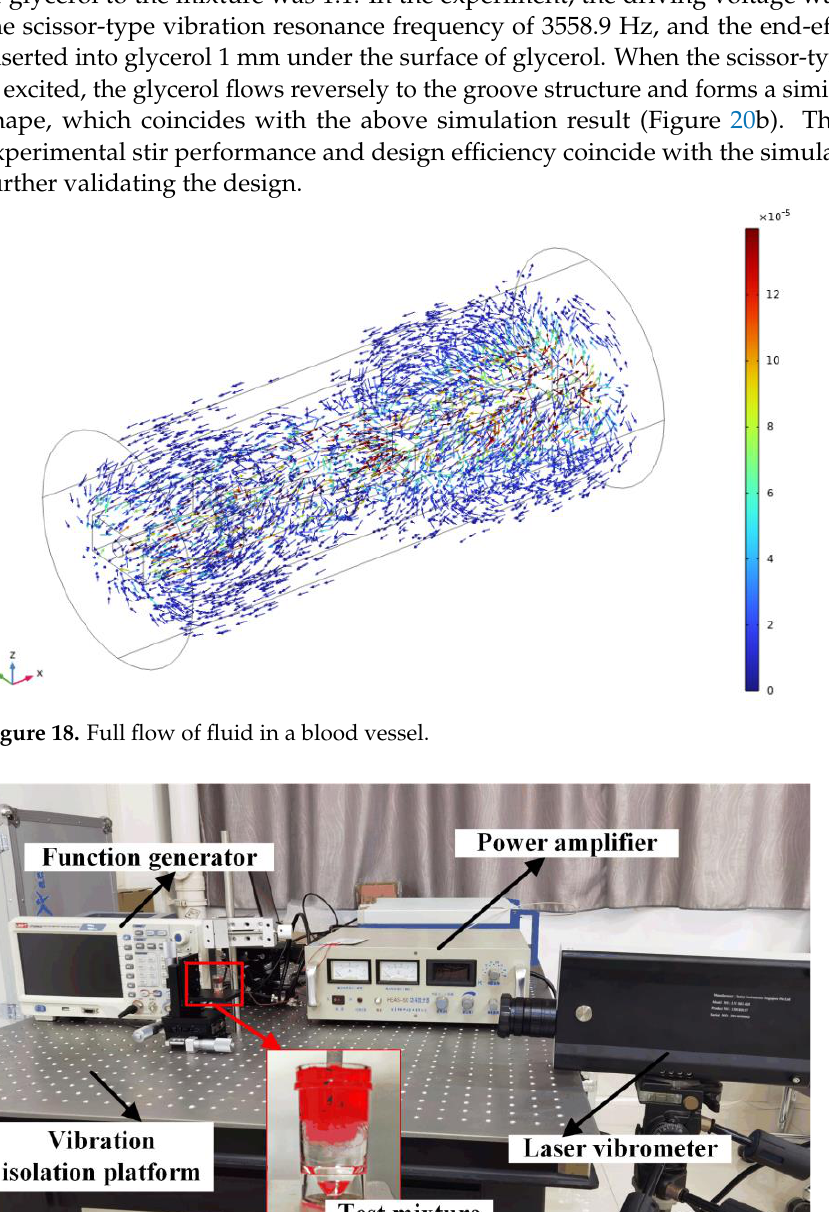
Figure 19. T he experiment setup of stirring performance test. Figure 19. The experiment setup of stirring performance